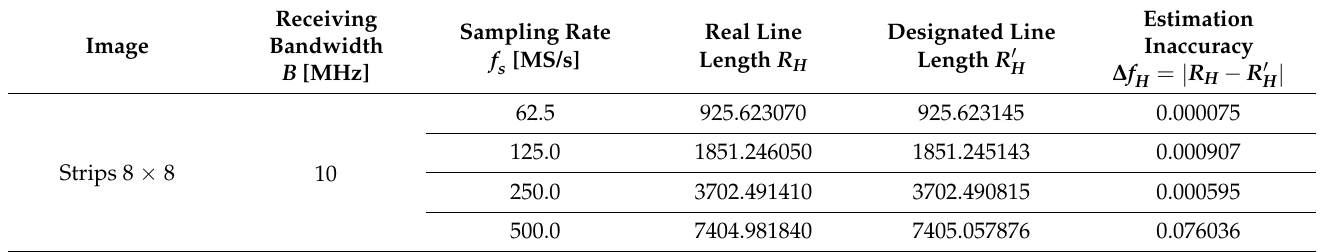
Table 10. Determination of the R H parameter for the reception frequency f o = 424 MHz, in the receiving bands BW = 10 and 20 MHz, with the antenna amplifier on (+10